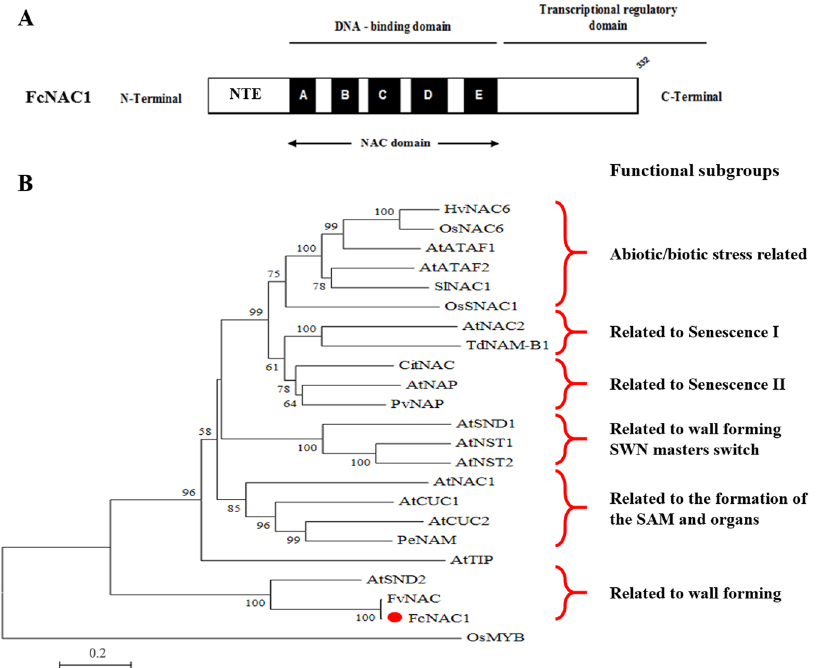
Figure 1. Schematic representation of FcNAC1 protein and phylogenetic analysis with NAC sequences. ( A ) Schematic representation of the primary structure of FcNAC1 showing the NTE (N terminal extension), the DNA binding domain (NAC domain) divided into five subdomains (A to E), and the transcriptional regulatory domain, as described in Puranik et al . 24 . ( B ) Phylogenetic analysis where FcNAC1 groups with members of the NAC family related to wall formation, close to AtSND2. We used amino acid sequences of NAC members with described function: AtNAC2 (AB049071.1), AtNAP (NM_105616.4), AtCUC1 (EU550396.1), AtCUC2 (AB002560), HvNAC6 (AM500854.1), AtNAC1 (NP_175997), TdNAM-B1 (KF541318), AtNST1 (NM_130243), AtSND1 (EF101892), AtSND2 (NC_003075.7), AtNST2 (NP_191750), OsNAC6 (AB028185.1), PeNAM (X92205), PvNAP (XP_007158644), SlNAC1 (NM_001247553.3), OsSNAC1 (KM265360.1), and AtTIP (NP_197847). The transcription factor OsMYB (CAA72218) was used as outlier. The phylogenetic tree was performed with MEGA5 software employing the neighbor joining method, with 1000